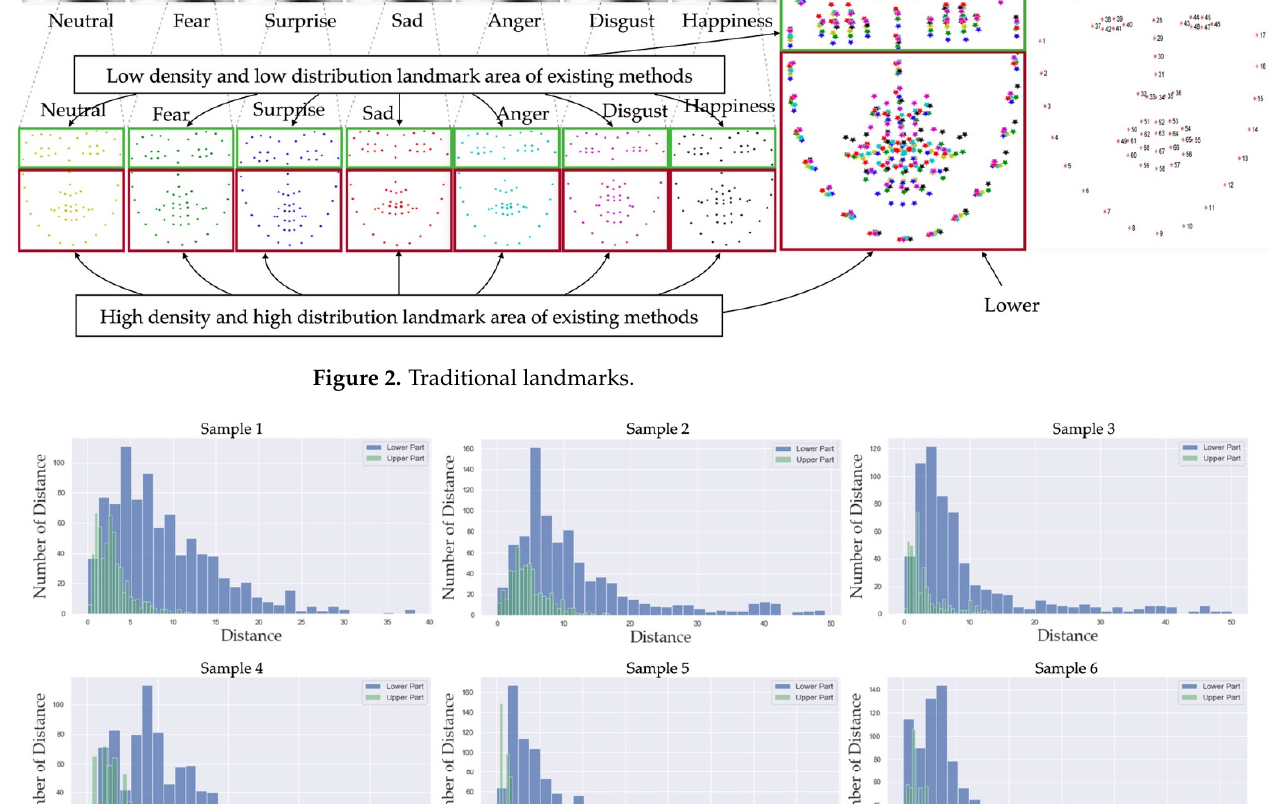
Figure 3. Histograms of the distance between landmarks across all emotions from nine CK+ samples.